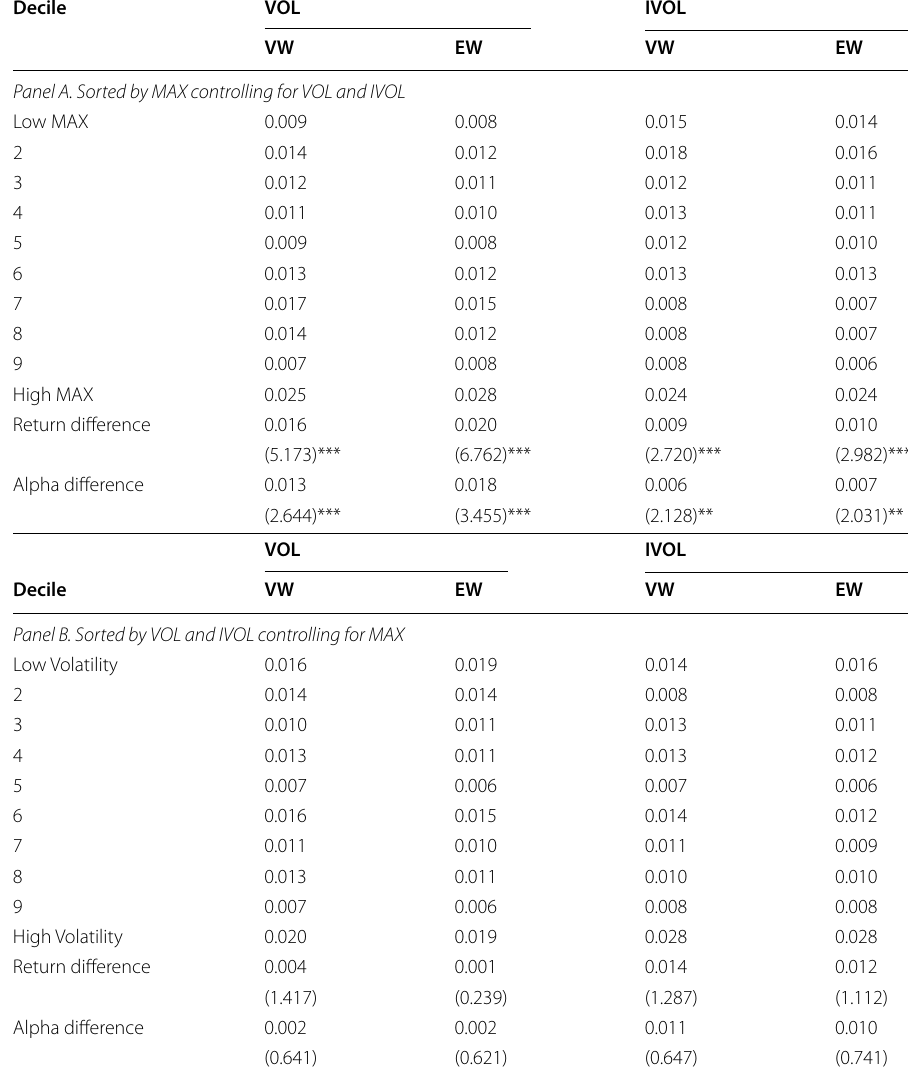
Table 10 Returns on portfolios of cryptocurrencies sorted by MAX and volatility after controlling for volatility and